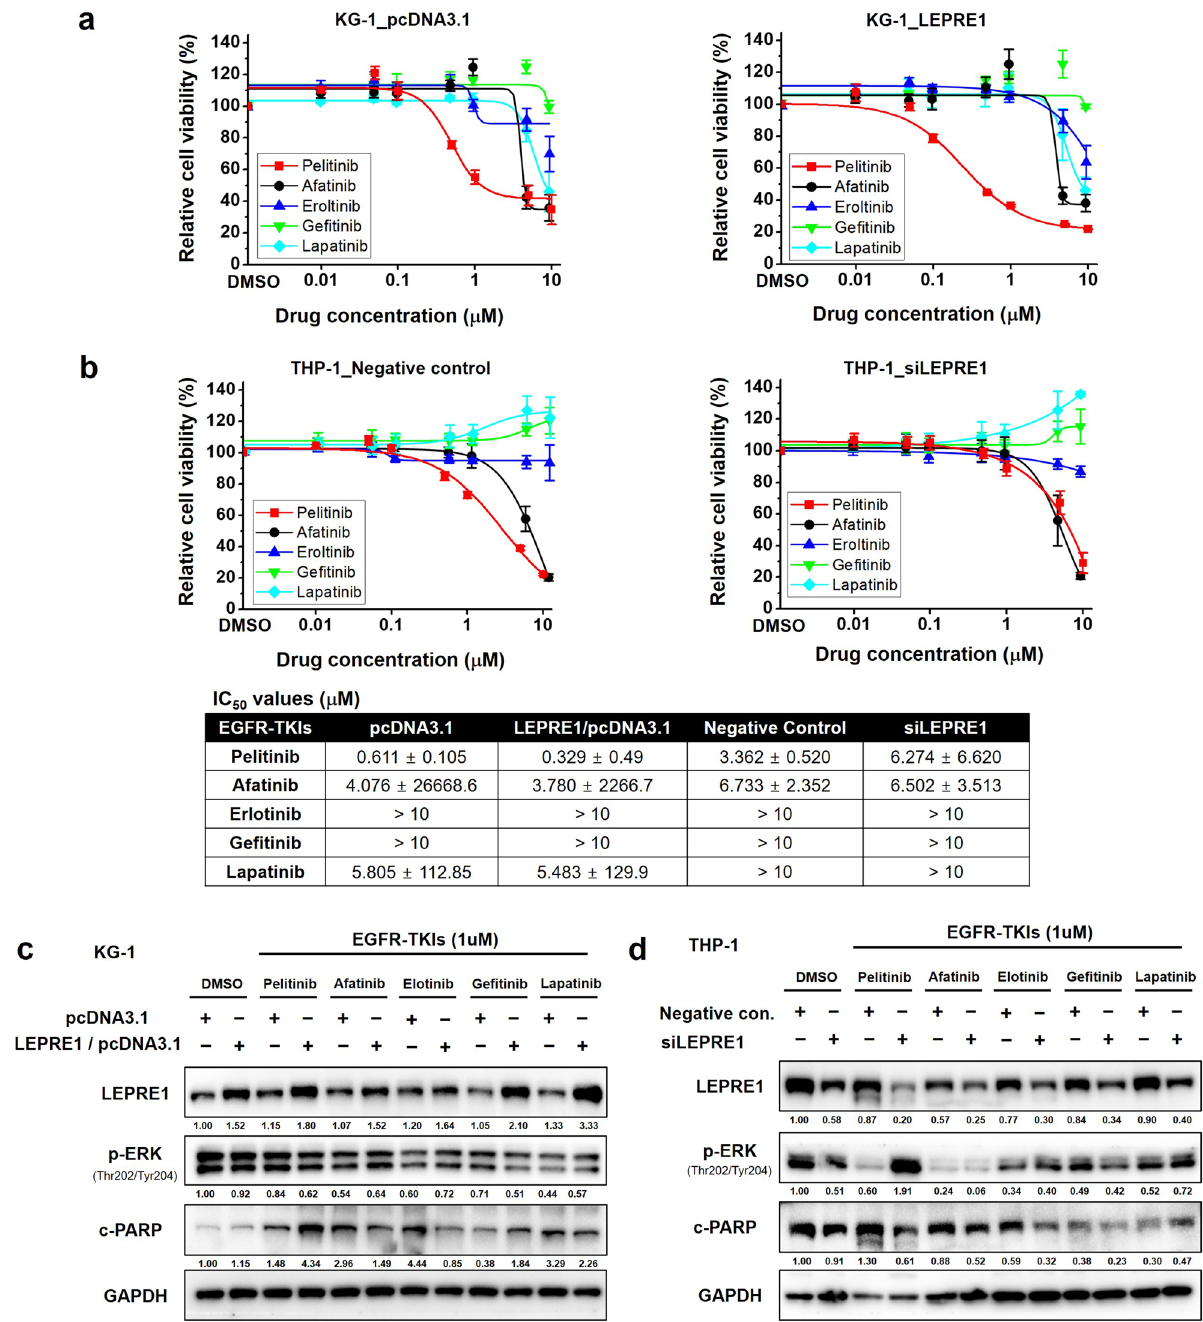
Figure 3. Effect of EGFR-TKIs on LEPRE1 overexpression or knockdown AML cells. (a , b ) pcDNA3.1 and LEPRE1/pcDNA3.1 were transfected into KG-1 cells ( a ) or Negative control siRNA, and siLEPRE1 were transfected into THP-1 cells ( b ) and then incubated with EGFR-TKIs (afatinib, erlotinib, gefitinib, lapatinib, and pelitinib) for 72 h. Cell viability was determined using WST-1 proliferation assays. The IC 50 value for each condition is presented in the lower panel. ( c , d ) Transfected cells were incubated with EGFR-TKIs (1 μM) for 24 h. Thereafter, cell lysates were prepared and immunoblotted for phosphorylated ERK (p-ERK) and cleaved PARP (c-PARP), as indicated. All western blots are pre-cut. Membranes were often stripped and reprobed for multiple